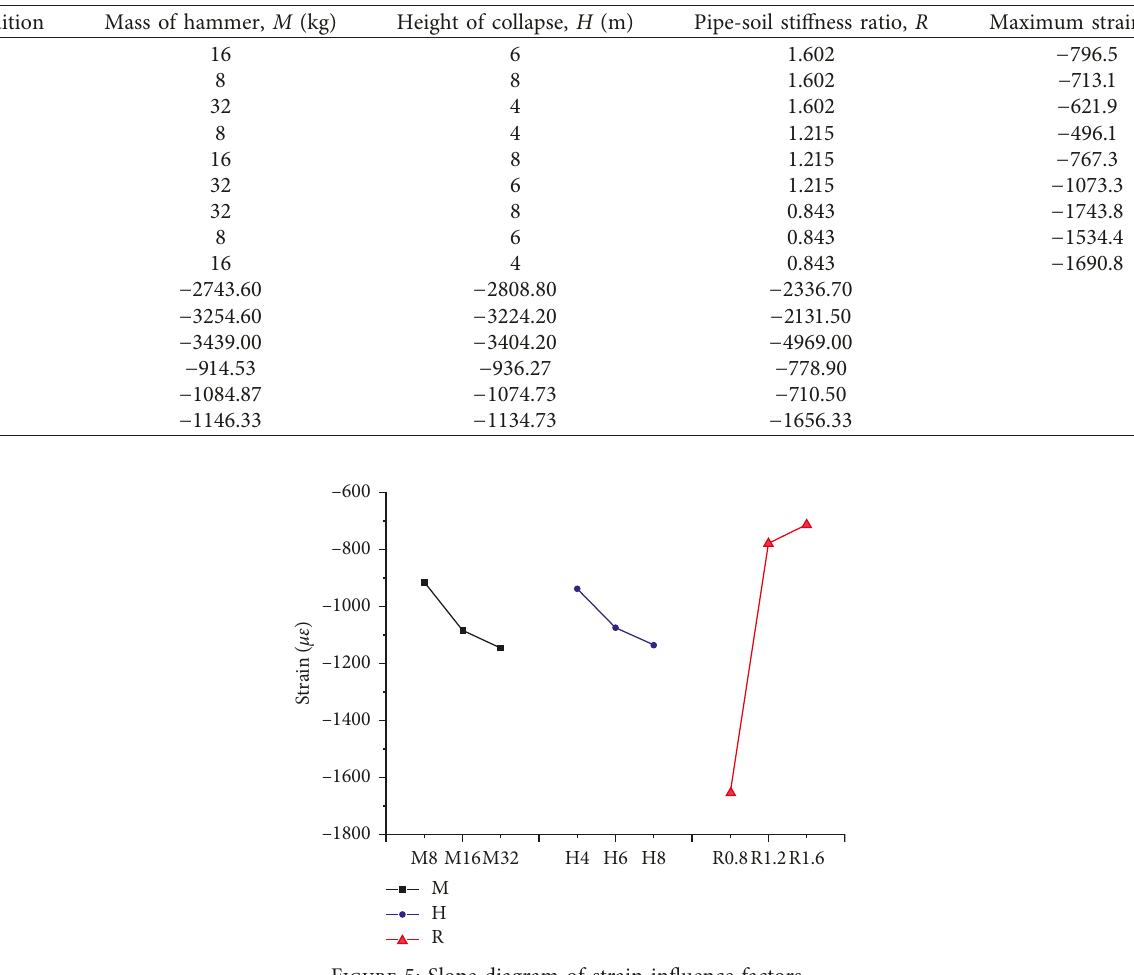
Table 4: Range analysis table.